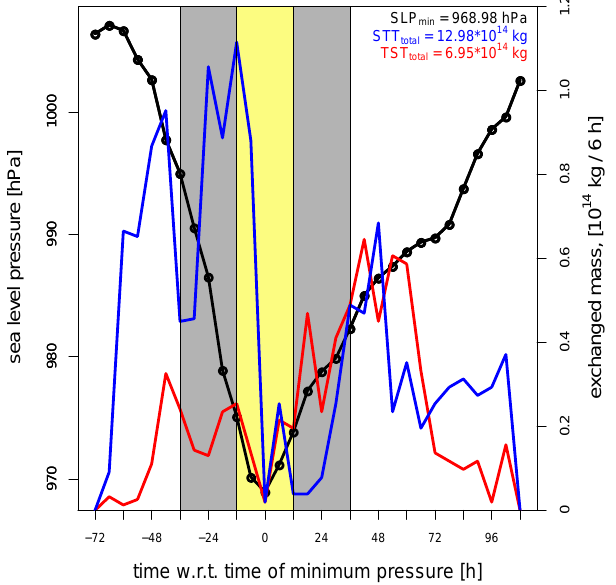
Figure 1. Time series of SLP (hPa) in black and the exchanged mass (10 14 kg) of STT (blue) and TST (red) as a function of time (h) with respect to the time of minimum SLP of cyclone “Xynthia”. 0h corresponds with 00:00UTC of 28 February 2010. The grey boxes correspond to the deepening and decaying phase of the cyclone, respectively, and the yellow box indicates the mature phase. The separation into phases is later used for the analysis in Sect. 4.3 (see also Figs. 9 and 10).